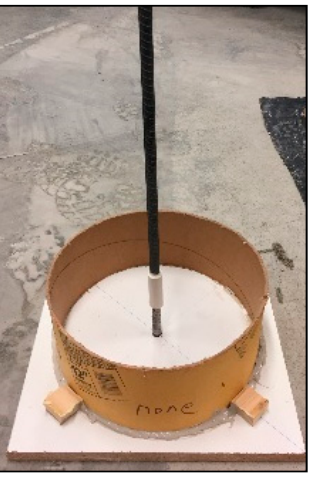
Figure 2. Pull-out test specimen.